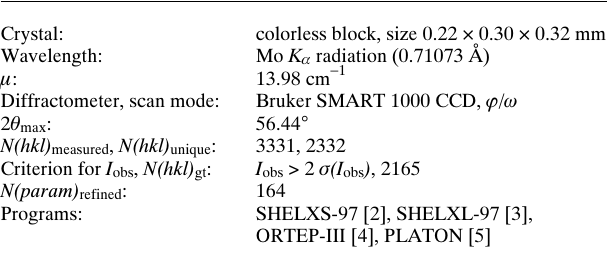
Table 1. Data collection and